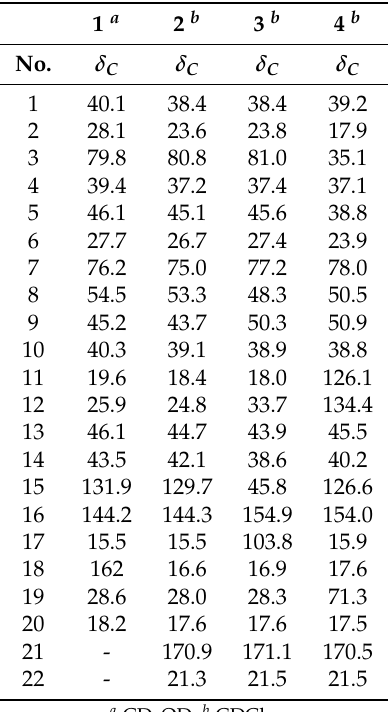
Table 2. 13 C NMR data of compounds 1 – 4 ( 13 C 125